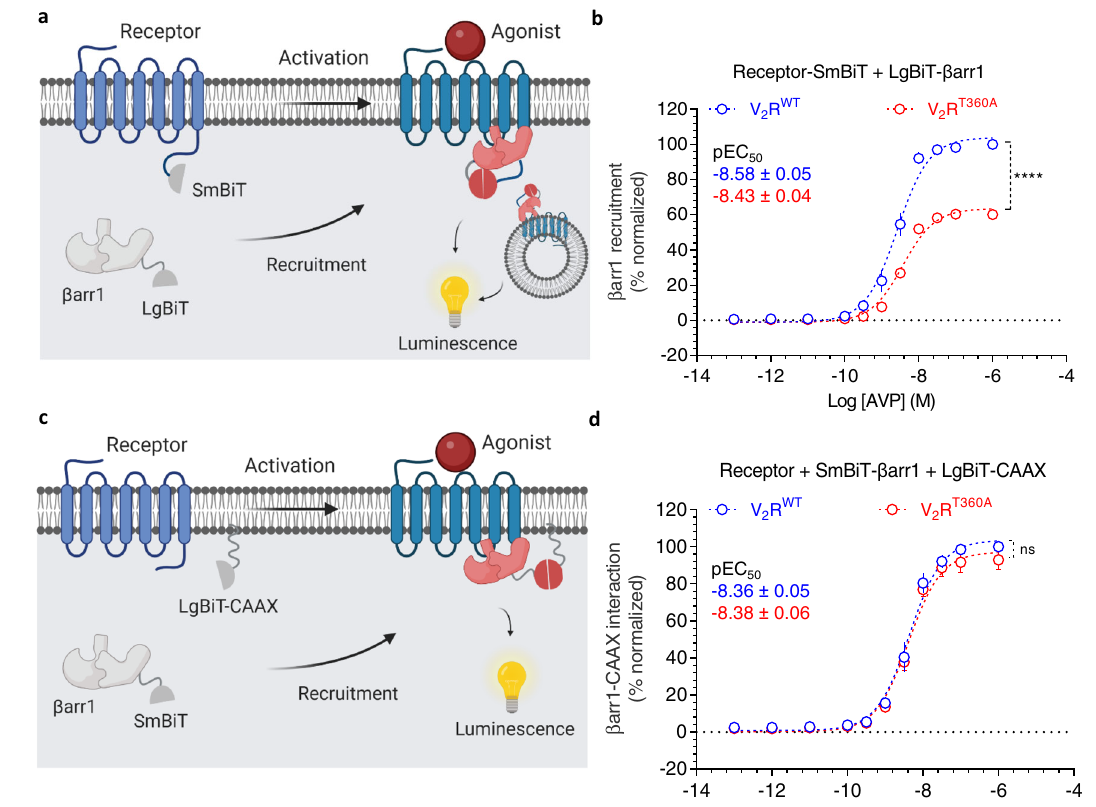
Fig. 4 | Agonist-induced β arr1 recruitment to V 2 R WT and V 2 R T360A mutant. a Schematic representation of NanoBiT-based β arr1 recruitment assay. b HEK-293 cells expressing the indicated receptor and β arr1 constructs were stimulated with varying doses of AVP for 30min followed by the measurement of luminescence (mean±SEM; n =4 independent experiments; normalized with luminescence sig- nal for V 2 R WT at maximal ligand dose as 100%, Two-way ANOVA, Sidak ’ s multiple comparisons test; **** p <0.0001). c Schematic representation of NanoBiT-based